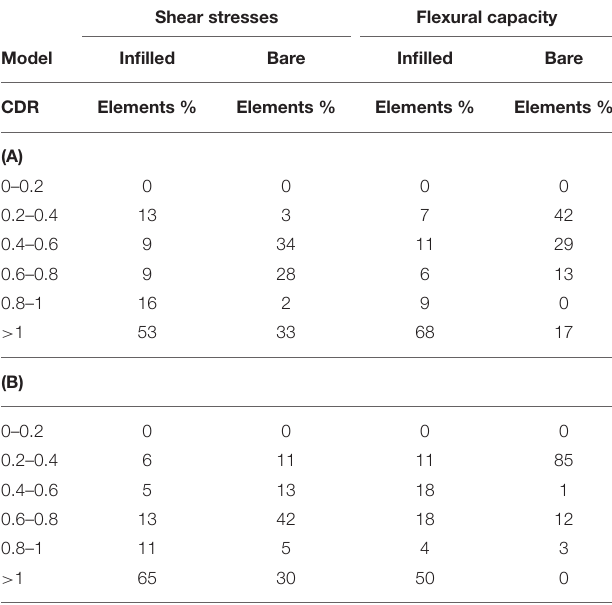
TABLE 5 | Capacity/demand ratio of shear stress and flexural capacity of beams (A) and columns (B). Shear stresses Flexural